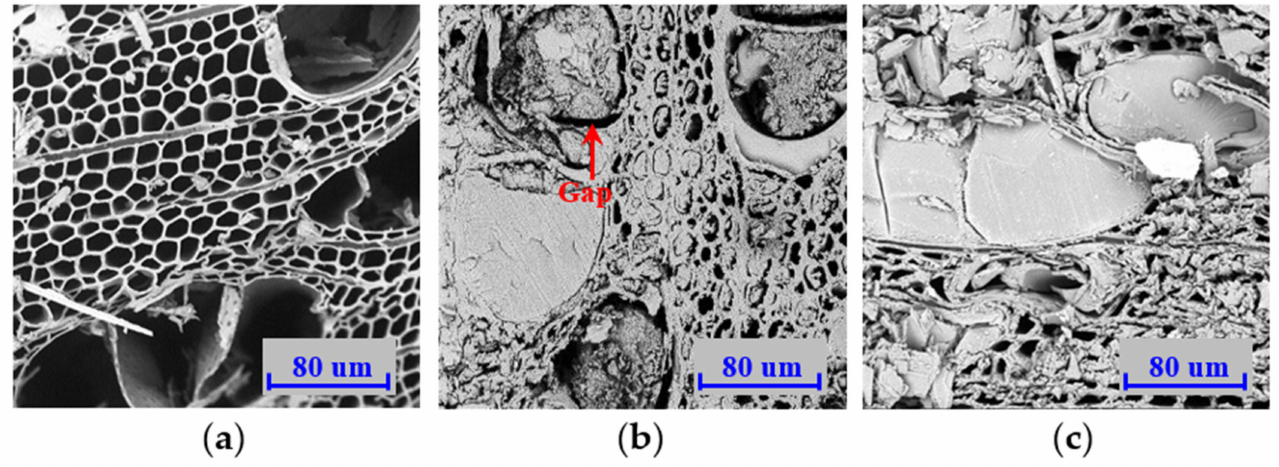
Figure 16. Transverse SEM images of control ( a ) and BPF specimens with 0 ( b ) and 20% ( c ) compres- sion ratios after cone